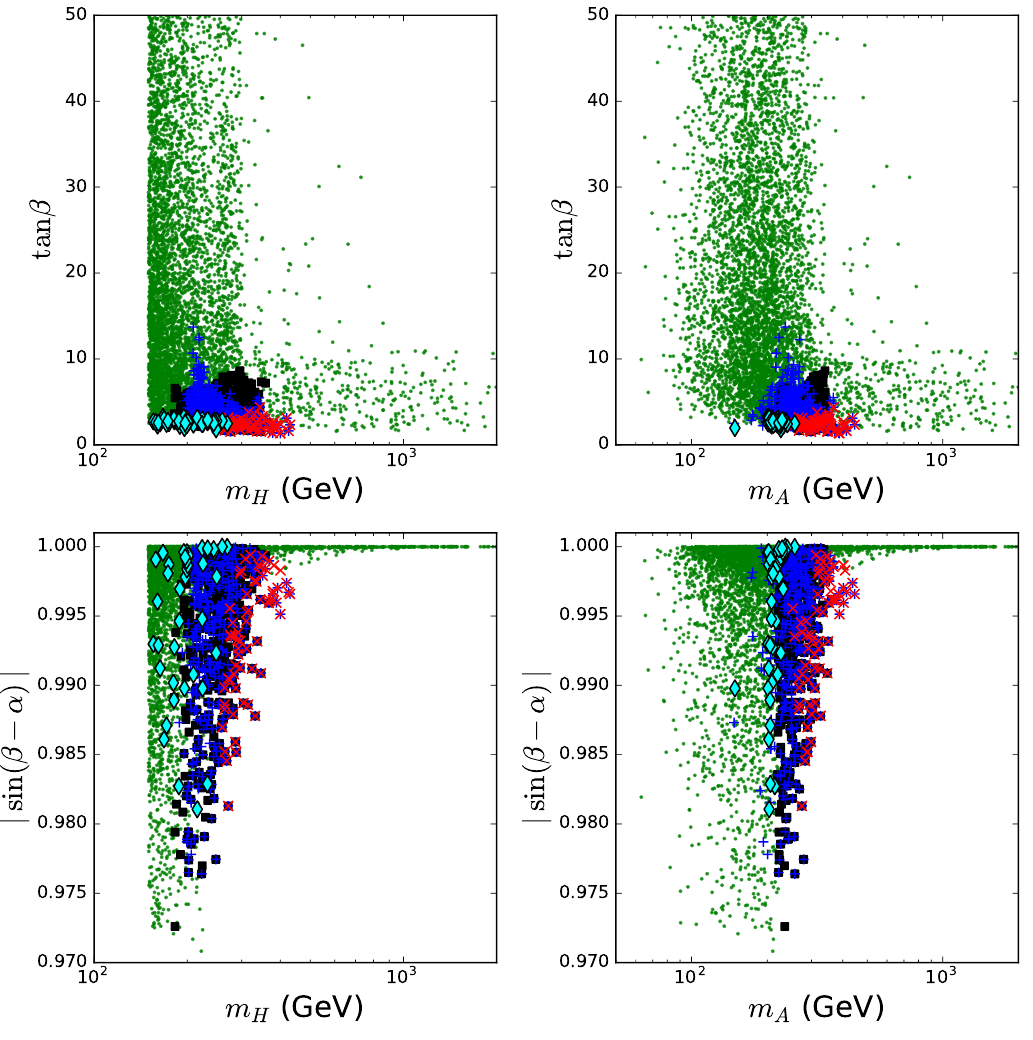
Figure 3 . In the type-I model, all the surviving samples satisfies the constraints of pre-inflation, h 2 -inflation, the exclusion limits from searches for Higgs at LEP, the flavor observables and R b . The pluses (blue), diamonds (cyan), crosses (red), and squares (black) are respectively excluded by H/A → V V, γγ , H/A → τ + τ − , H → hh , and A → hZ channels at the LHC. The bullets (green) are allowed by various LHC direct